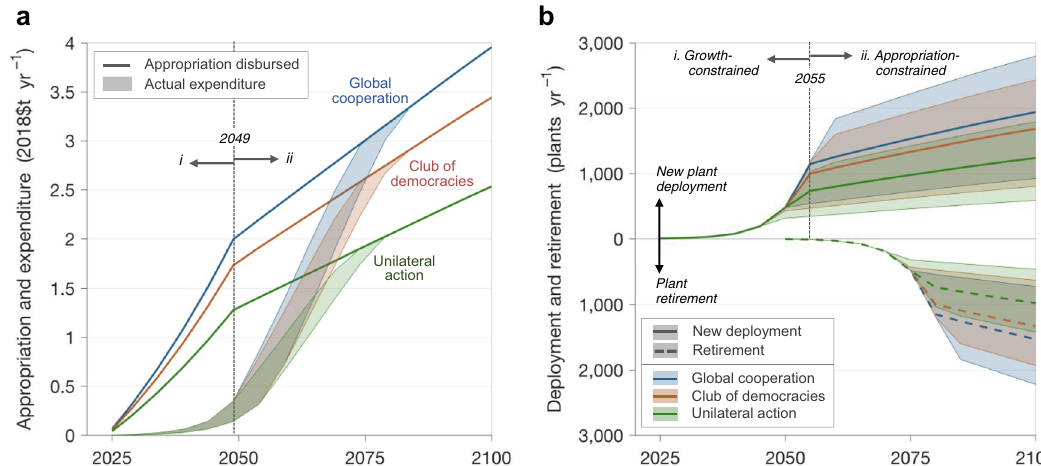
Fig. 2 Funding and deployment by funding regime. a Funding disbursed for DAC deployment and actual expenditure on DAC. The appropriation disbursed for deployment (lines) is the sum of annualized disbursements from each yearly allocation. There are two distinct periods of disbursement: (i) prior to 2050, disbursements increase rapidly as, year after year, a new DAC vintage begins operation; (ii) post-2050, disbursements level off as the number of DAC vintages operating saturates. Actual expenditure (ribbons; 15th and 85th percentile scenarios) is the total appropriation ultimately spent, given industry ’ s capability to scale up to use funds. Variation in expenditure stems from the differing costs of DAC process and energy supplies used. b New DAC plant deployment and retirement. Ribbons indicate 15th and 85th percentile scenarios; lines show medians. Over 2025 – 2055 (i), deployment grows exponentially and at maximum rate and is thus growth-constrained. Post-2055 (ii), growth is fi scally constrained and linear; further increases in plant deployment stem from falling plant costs and an appropriation growing with GDP. The result is logistic (S-shaped) growth. (See Supplementary Figs. 6 and 7 for deployment and fl eet size by